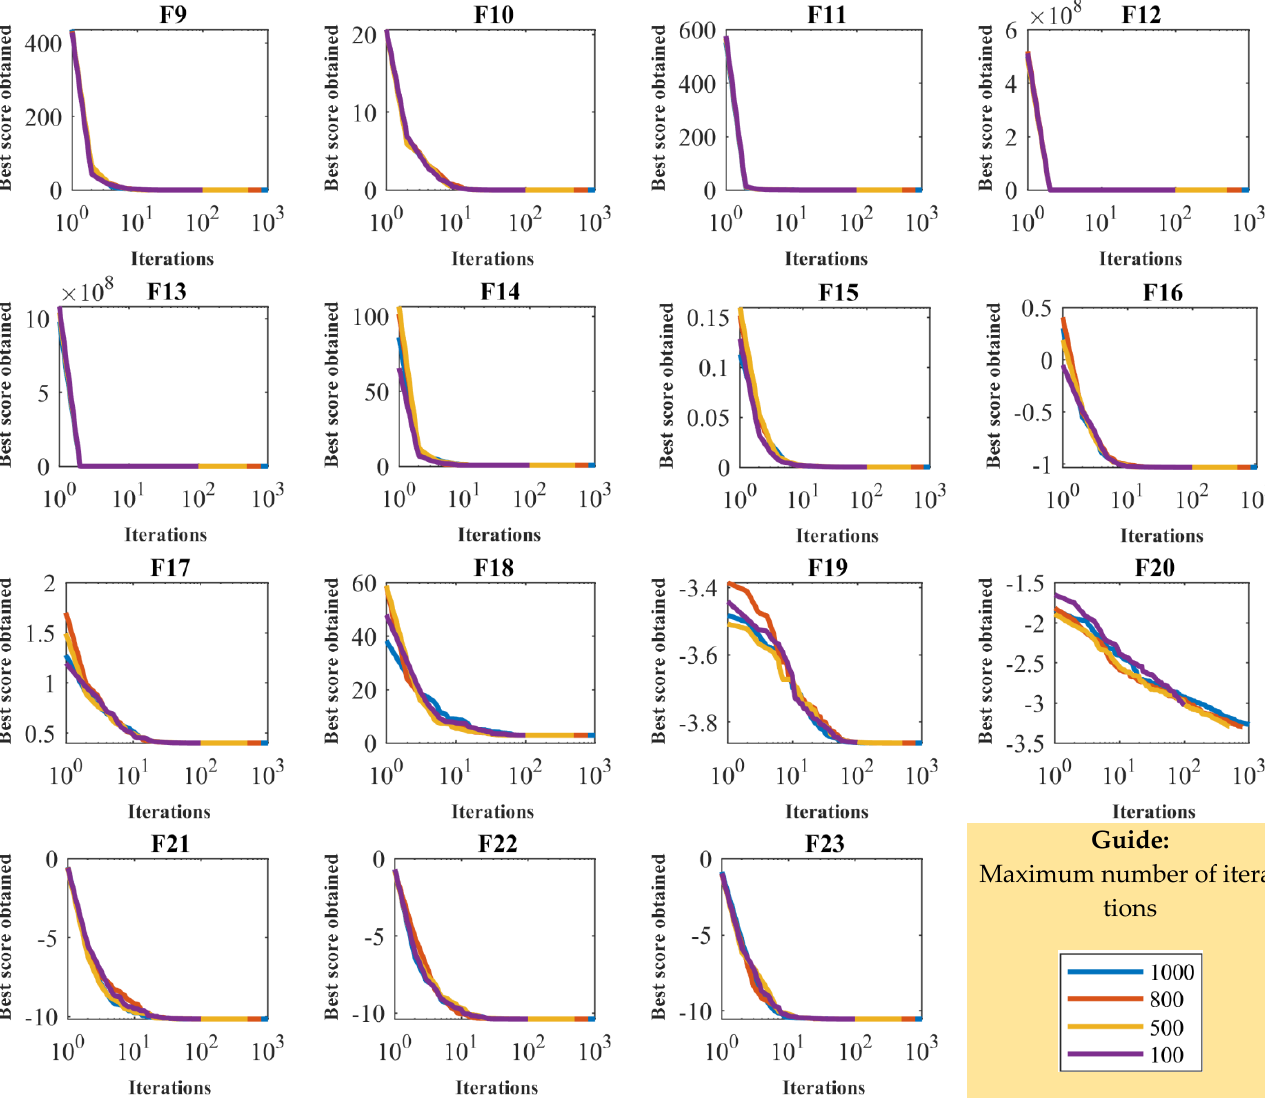
Figure 5. Sensitivity analysis of the SSVUBA for the maximum number of iterations.